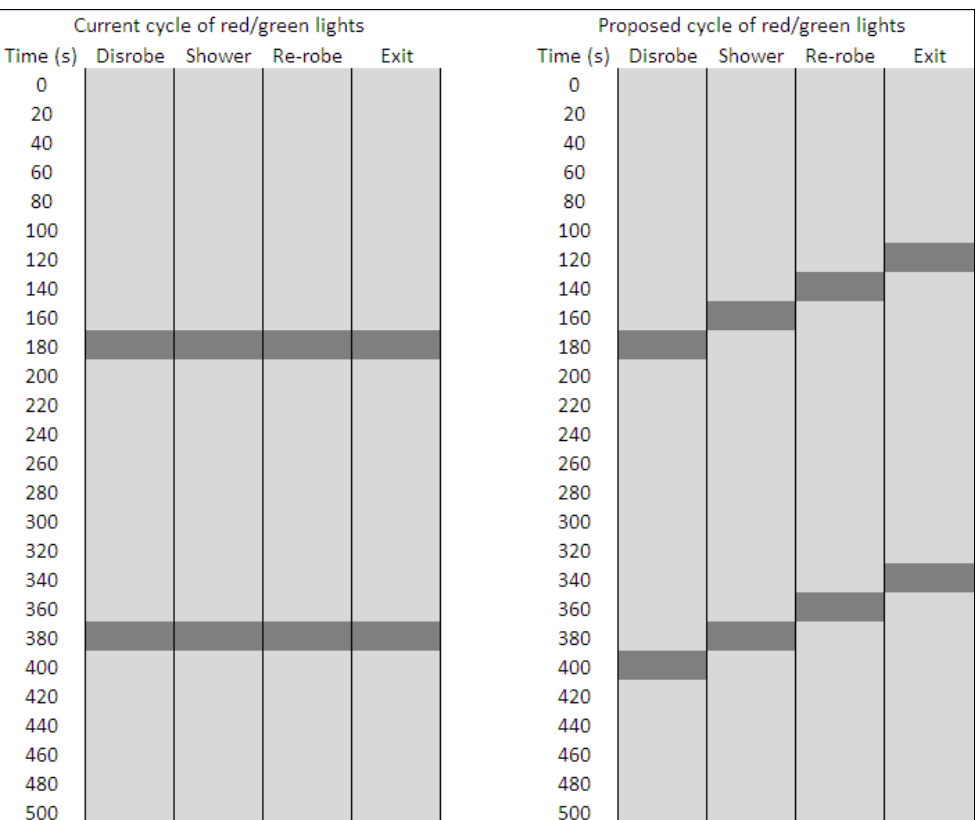
Figure 3. Current ( left ) and proposed ( right ) flow control system. The light and dark grey sections represent the time when the lights are illuminated red and green, respectively. ―Disrobe‖ refers to the final disrobe section as described in the main